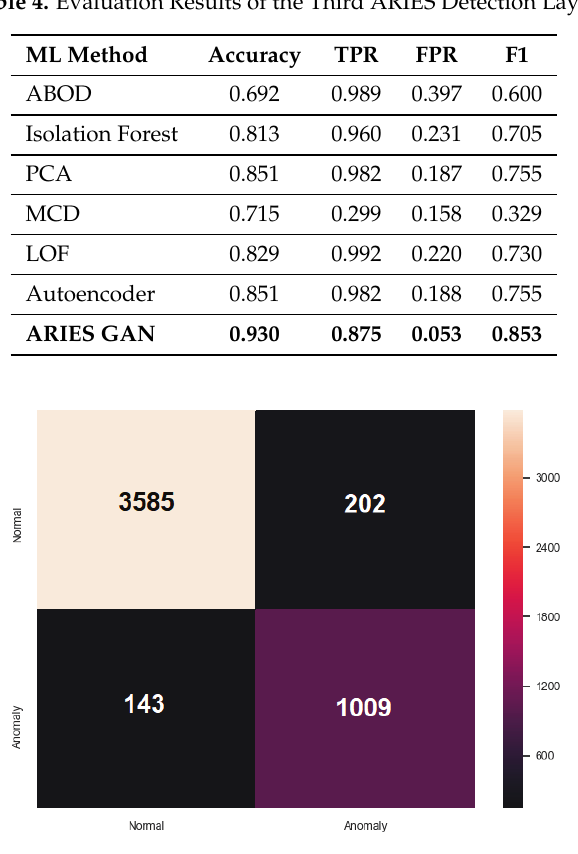
Figure 8. Confusion Matrix of ARIES Third Detection Layer (ARIES